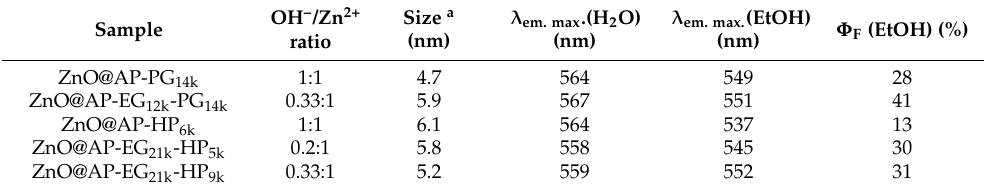
Table 4. Hydrodynamic diameter and photophysical properties of hybrid ZnO QDs synthesized in the presence of APTES (AP) and hydroxylated homopolymers and block copolymers.